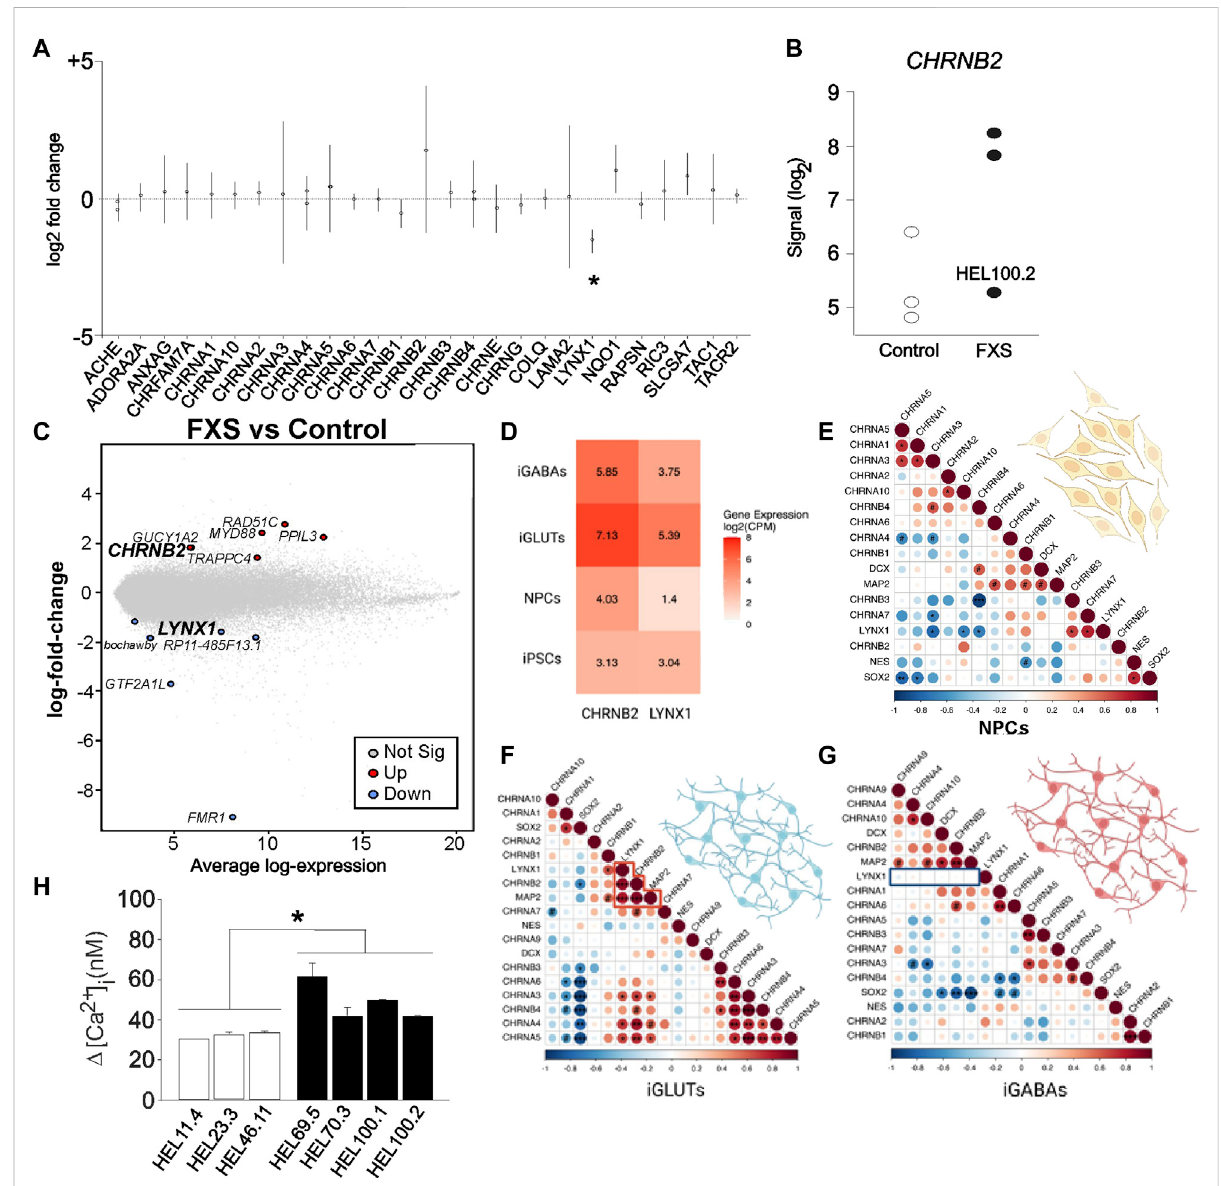
FIGURE 4 LYNX1 -related gene expression in FXS NPCs. (A) The log2 fold expression changes of genes assigned Gene Ontology (GO) term GO:0007271; synaptic transmission, cholinergic in transcriptomes of D7 FXS NPCs compared with controls. Statistical signi fi cance in adjusted p -values. (B) Expression of CHRNB2 inD7FXSandcontrol NPCs. (C) Geneexpression changesinD7FXS versus controlNPCsplottedwiththeaverageexpression levels of genes targeted in the array. The location of the signi fi cantly affected genes (adjusted p -value < 0.05) and the CHRNB2 gene are highlightedto show their relatively high average expressionvalues ( LYNX1 7.496 and CHRNB2 6.328). (D) Average gene expression [log2(CPM+1)] of CHRNB2 and LYNX1 across iPSCs and neuronal cell-types in matched control donor lines ( n = 9 – 11). (E) Gene expression of LYNX1 correlated with different nAChR subtypes in NPCs. (F) LYNX1 expression correlated with CHRNB2 expression in human iPSC-derived glutamatergic neurons (iGLUTs), (G) but not in human iPSC-derived GABAergic neurons (iGABAs), suggesting a potential role in co-expression of LYNX1 and nAChR subtypes in fate determination of neuronal lineages. Created with BioRender.com. (H) The mean amplitude of [Ca 2+ ] i responses to type I mGluR agonist DHPG in D7 NPCs derived from control (HEL46.11, HEL23.3, and HEL11.4) and FXS (HEL69.5, HEL70.3, HEL100.1 and HEL100.2) iPSC lines. Results are shown as mean ± SEM. * p <